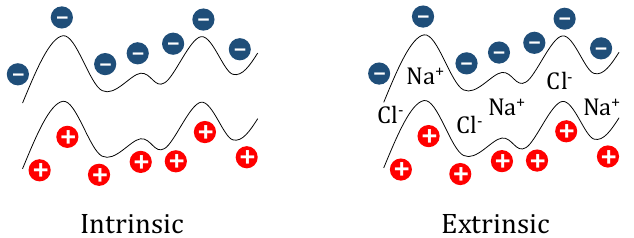
Figure 8. Idealized representation of polyelectrolyte layers and counterions in polyelectrolyte multilayers presenting intrinsic and extrinsic compensation mechanisms. Reprinted from Mateos ‐